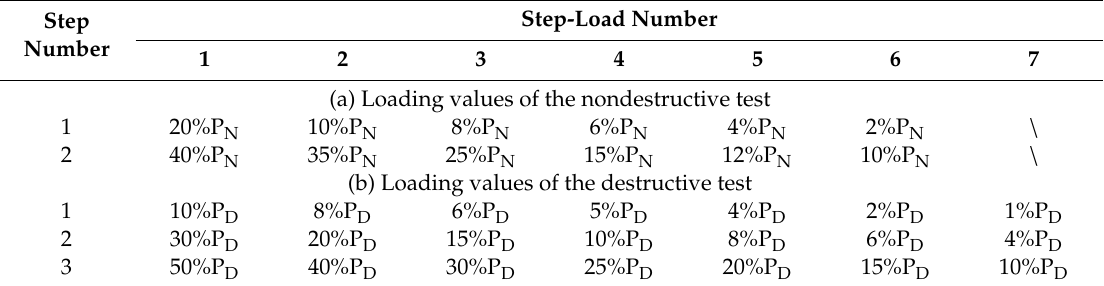
Table 1. Values of the step-load for the first